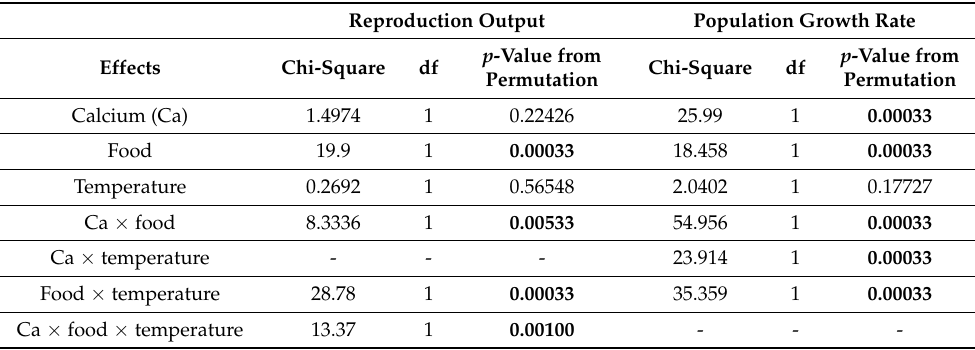
Table 3. Results of linear mixed-effects models (LMMs) with null model permutation tests for the effect of calcium concentration (log-transformed data), food concentration, and temperature on the reproduction output and population growth rate of D. pulex